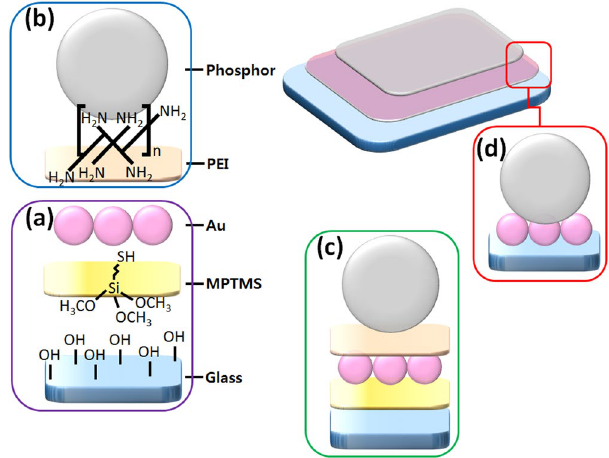
Figure 1. Schematic illustration of a dual functional hybrid film. Formation of Au monolayer on substrate with MPTMS ( a ), phosphor monolayer by polymer induced manual assembly ( b ), phosphor-stacked Au monolayer on substrate ( c ) and Au@phosphor dual function hybrid film ( d